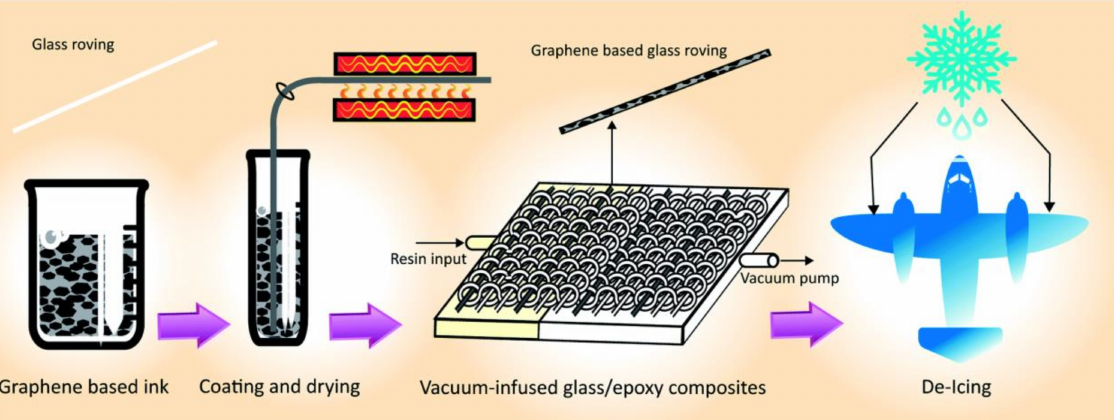
Figure 4. A dip-dry-cure technique for manufacturing graphene-based glass/epoxy composites for de-icing applica- tions [63].